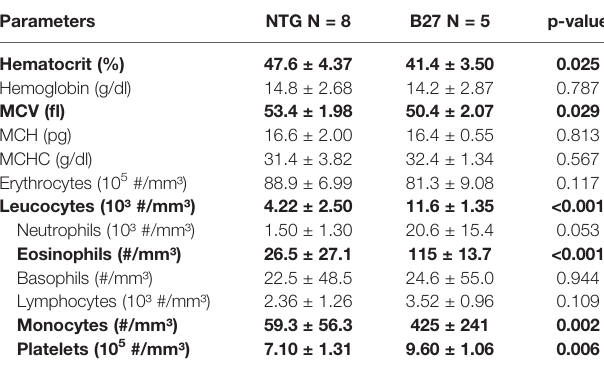
TABLE 2 | Blood differential in no-transgenic and HLA-B27 transgenic rats.